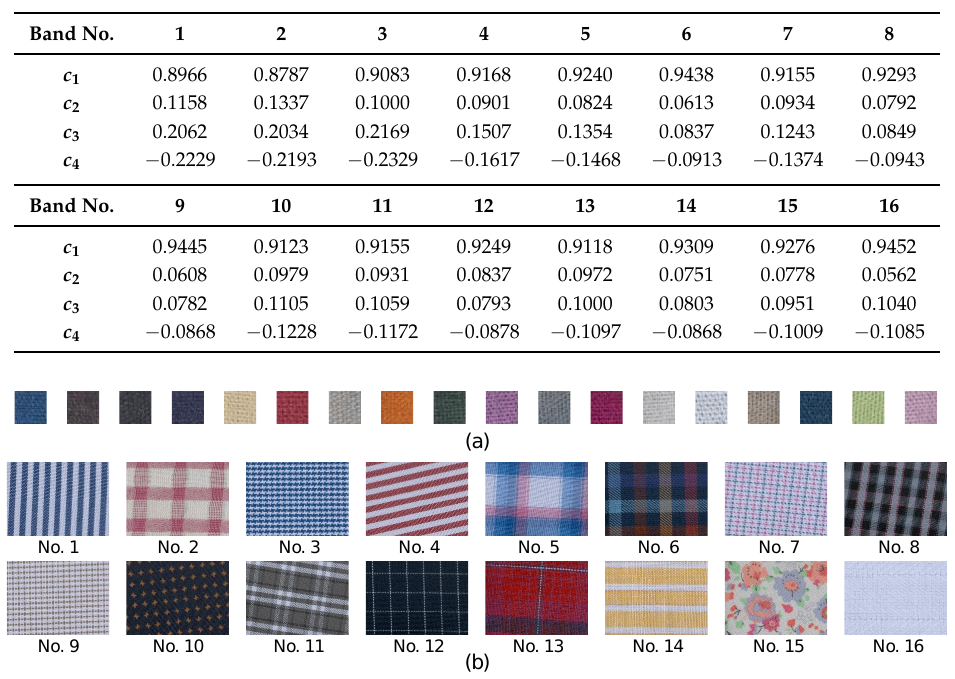
Figure 4. Test data collection. ( a ) Small color patches. ( b ) Background samples with various